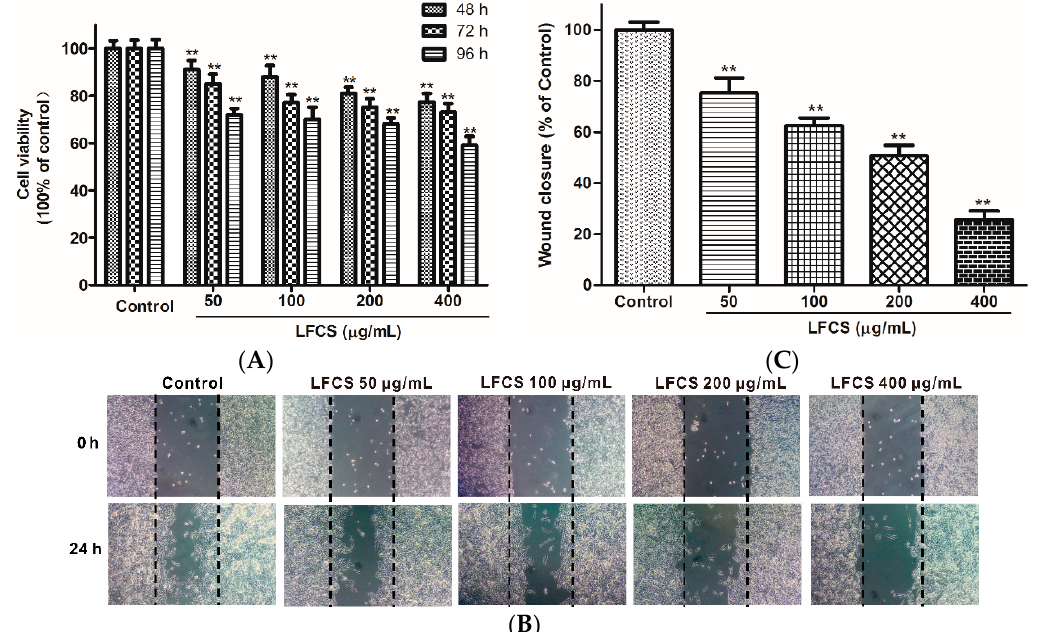
Figure 4. LFCS suppressed proliferation and cell migration of HUVEC. ( A ) Inhibitory effect of LFCS on HUVEC proliferation. HUVEC were treated with 50, 100, 200, and 400 μ g/mL LFCS separately for 48 h, 72 h, and 96 h and measured for viability by MTT assay. Values relative to that of control group (in which cell viability is set as 100%) were shown; ( B ) inhibitory effect of LFCS on HUVEC migration. Representative photos of wound closures after treatment with LFCS or not (10× magnification); and ( C ) quantification of the effect of LFCS on HUVEC migration. Wound closure relative to that of control group (in which wound closure is set as 100%). Data were derived from three independent experiments and presented as mean ± SD. ** p < 0.01, significant difference compared with control group.